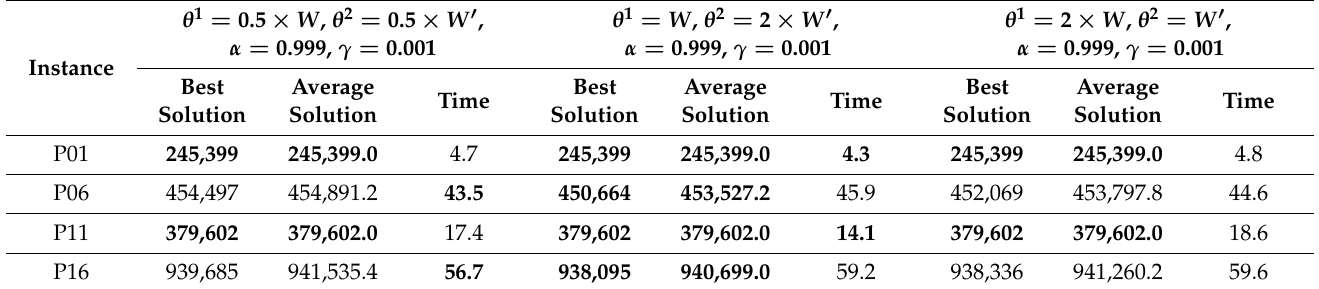
Table 3. The result of instances by HCDBAVNS with different θ 1 and θ 2 .